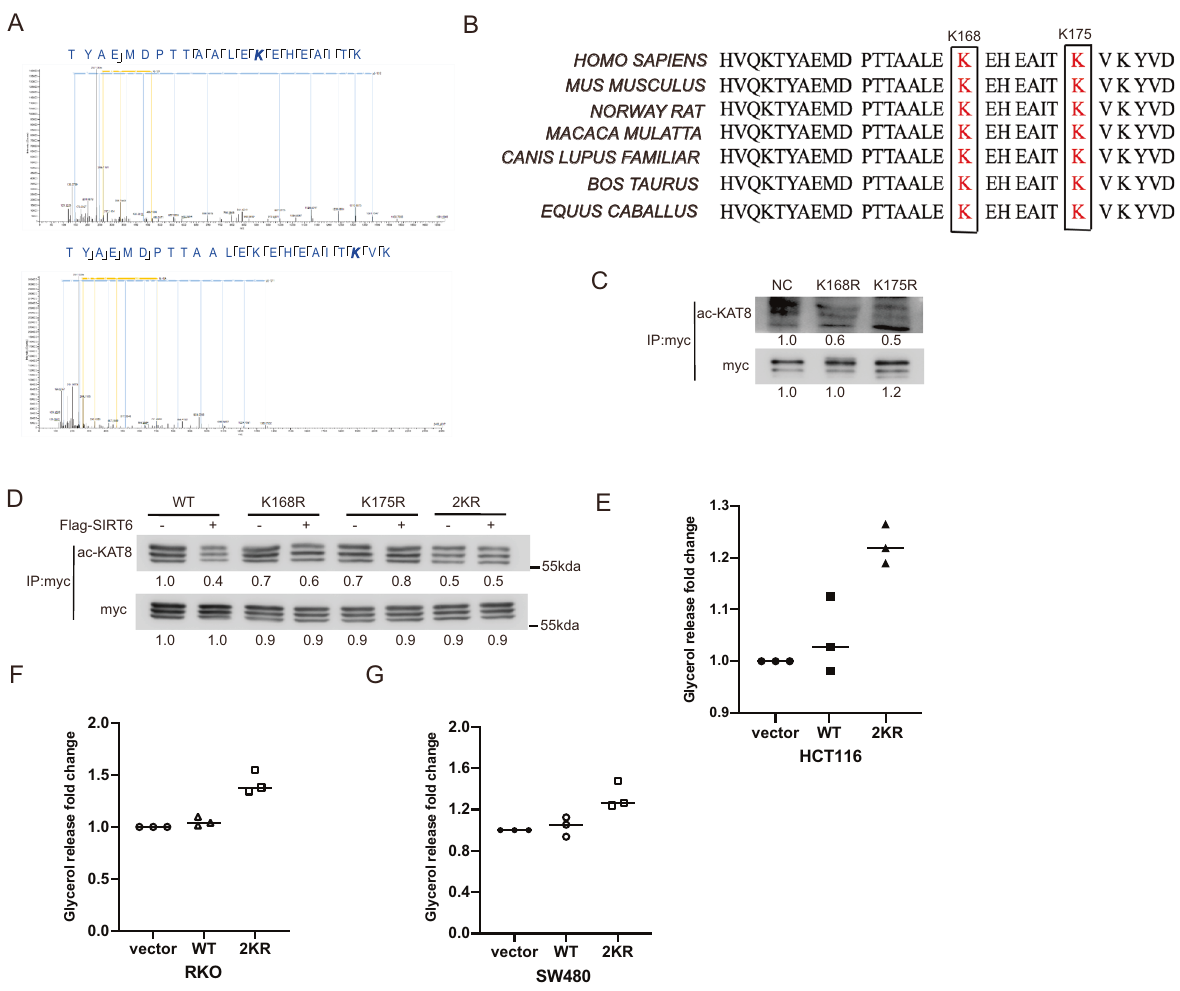
Fig. 5 Lysine 168 and lysine 175 are the major acetylation sites of KAT8 and mediate lipolysis of CRC cells. A HCT116 cells were transfected with myc-KAT8 and then treated with PA at 0.2 mM for 24 h. Myc-KAT8 was puri fi ed and subsequently separated by SDS-PAGE and stained with CBB. The KAT8 band was analyzed by mass spectrometry. B Alignment of MS-characterized putative KAT8 acetylation residues among different species. C HCT116 cells were transfected with myc-KAT8 WT, K168R or K175R mutant plasmids for a Co-IP assay to detect the level of KAT8 acetylation. D HCT116 cells were transfected with the plasmids above combined with Flag-SIRT6 for a Co-IP assay to detect the level of KAT8 acetylation. E-G HCT116 ( E ), RKO ( F ) and SW480 ( G ) cells were transfected with myc-vector, myc-KAT8 WT or myc-KAT8 2KR mutant plasmids, and then cells were lysed to quantify the amount of glycerol inside cells by glycerol colorimetric assay kit. The bar ( − ) represents the means ( n = treated with PA at 0.1 mM for 24 h after HSL siRNA or non-speci fi c siRNA were transfected into these cells. A wound-healing assay and matrigel-coated invasion assay were performed to evaluate the migration and invasion ability of HSL in HCT116 cells. These data showed that knocking down HSL effectively inhibited KAT8 (2KR) promoted the migration and invasion of HCT116 cells by PA stimulation (Fig. 8D – G). Also, the familiar phenomena were shown in RKO and SW480 cells (Fig. 8H – K). Together, these data demonstrate that KAT8 acetylation regulates migration and invasion through HSL in CRC cells.